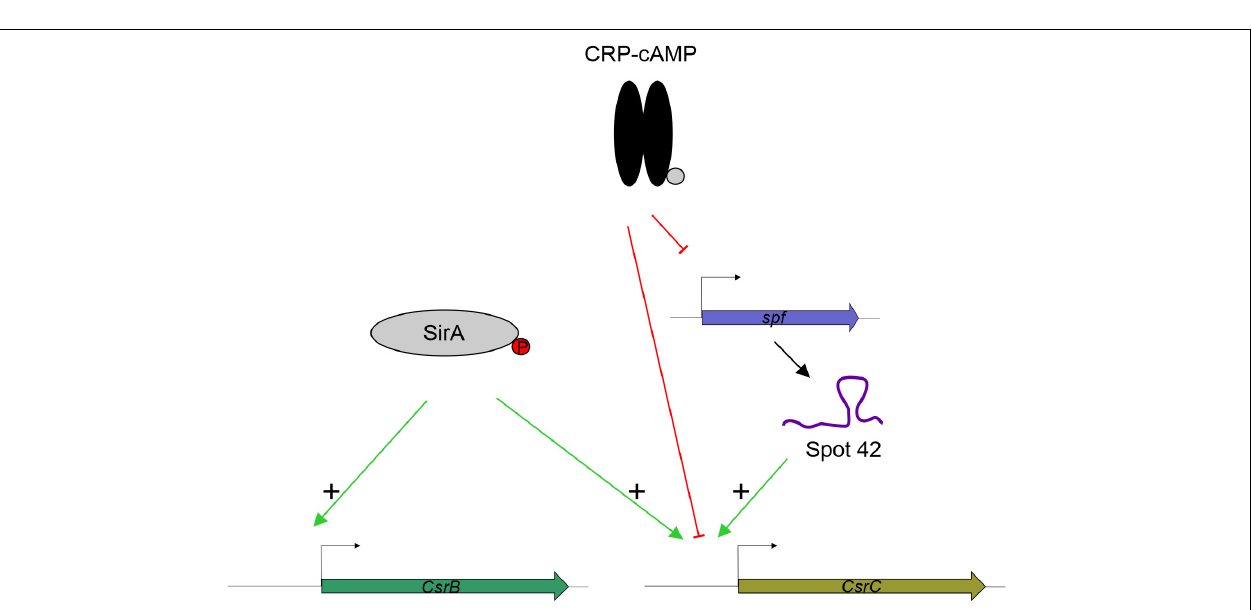
FIGURE 6 | Proposed model for CRP-cAMP mediated repression of CsrC at the logarithmic growth phase. In green, positive regulation is indicated. In red, negative regulation is indicated. SirA, when phosphorylated, it positively regulates CsrB and CsrC. CRP-cAMP represses CsrC and Spot 42. In addition, Spot 42 positively regulates CsrC